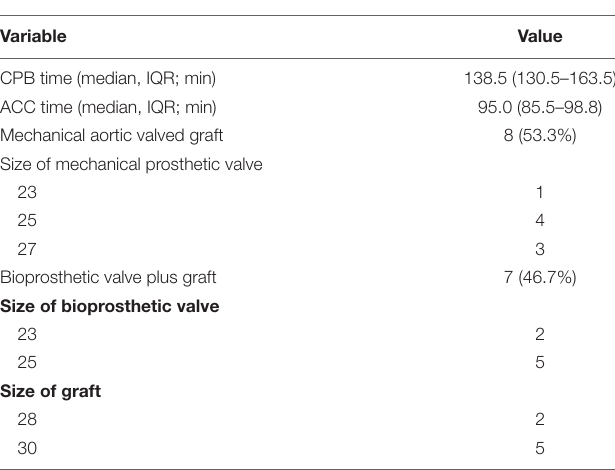
TABLE 2 | Procedure